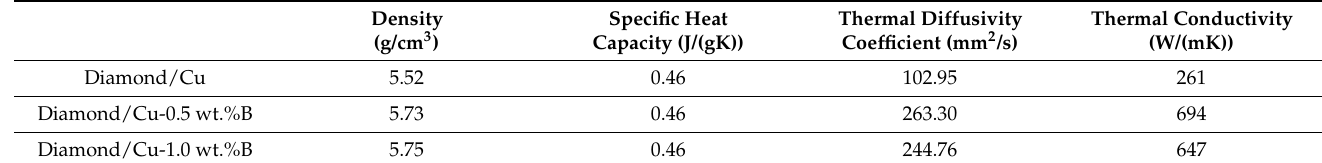
Table 2. Thermal physical properties of diamond/Cu and diamond/Cu-B composites.